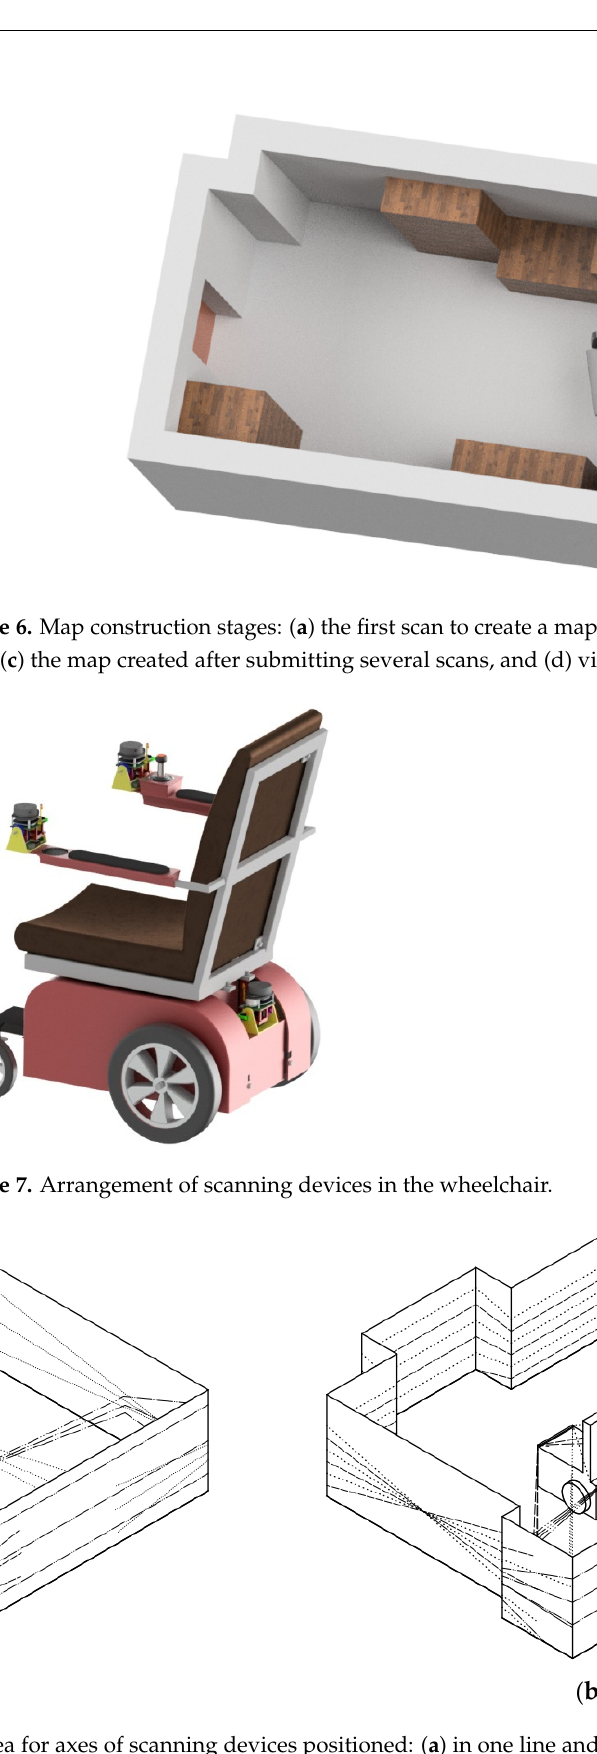
Figure 8. Scanning area for axes of scanning devices positioned: ( a ) in one line and ( b ) not parallel.